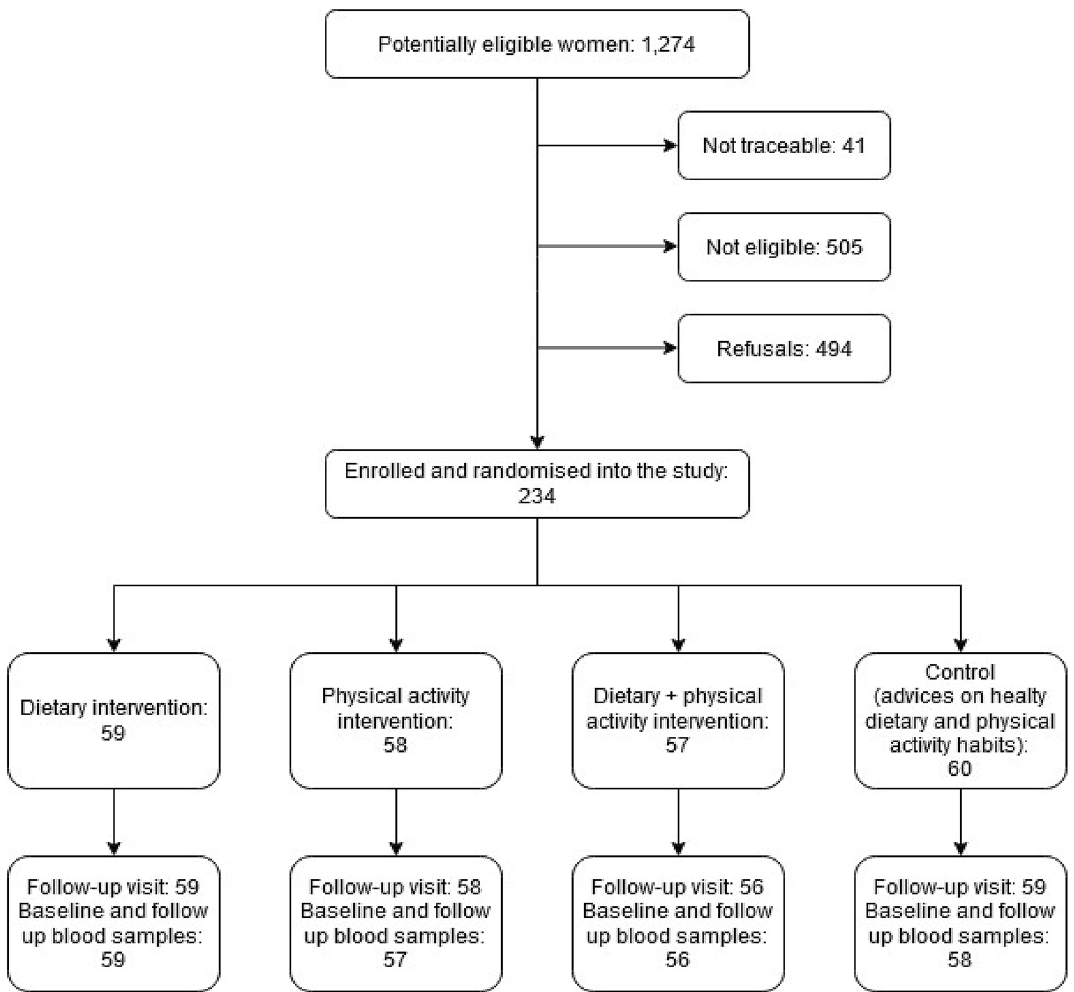
Figure 1. Recruitment of participants, randomisation and follow-up in the DAMA factorial intervention trial. CONSORT Flow Diagram showing procedures of selection among eligible women and participants with complete data